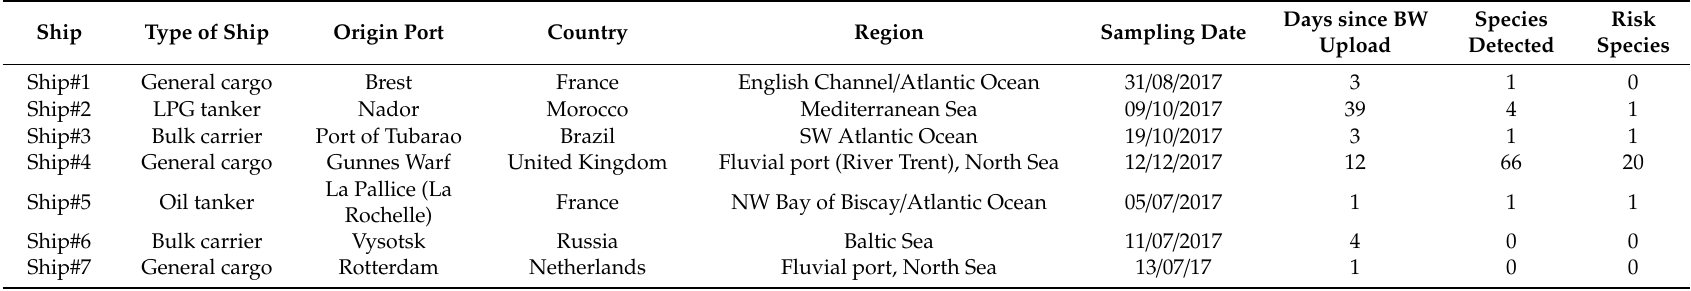
Table 1. Ballast water analysed, number of algae species, and number of risk species (exotic and / or harmful) detected employing DNA metabarcoding methodology in this